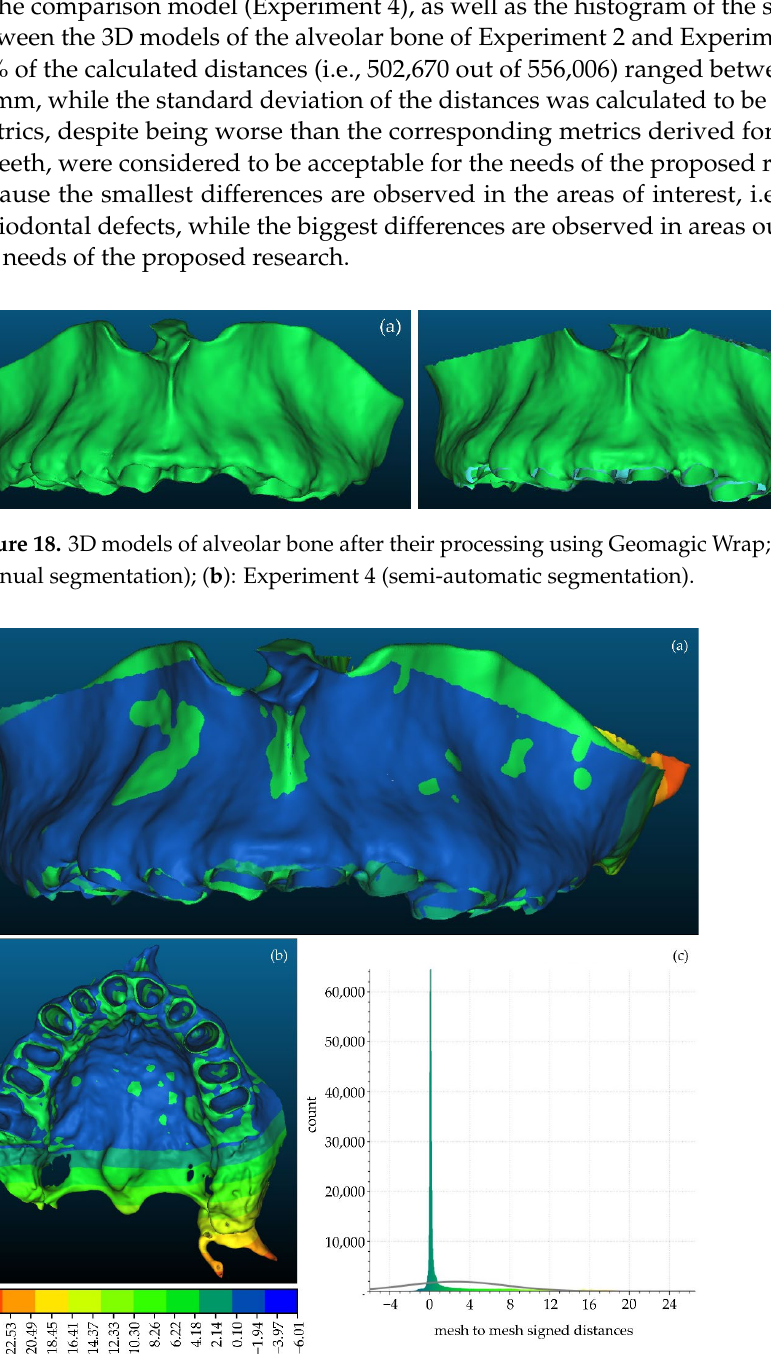
Figure 19. ( a , b ): Differences between the manually segmented 3D model of teeth of Experiment 2 (reference model) and the semi-automatically segmented 3D model of teeth of Experiment 4 (com- parison model), visualized in the comparison model; ( c ) histogram of the distances between the aforementioned 3D models of teeth.